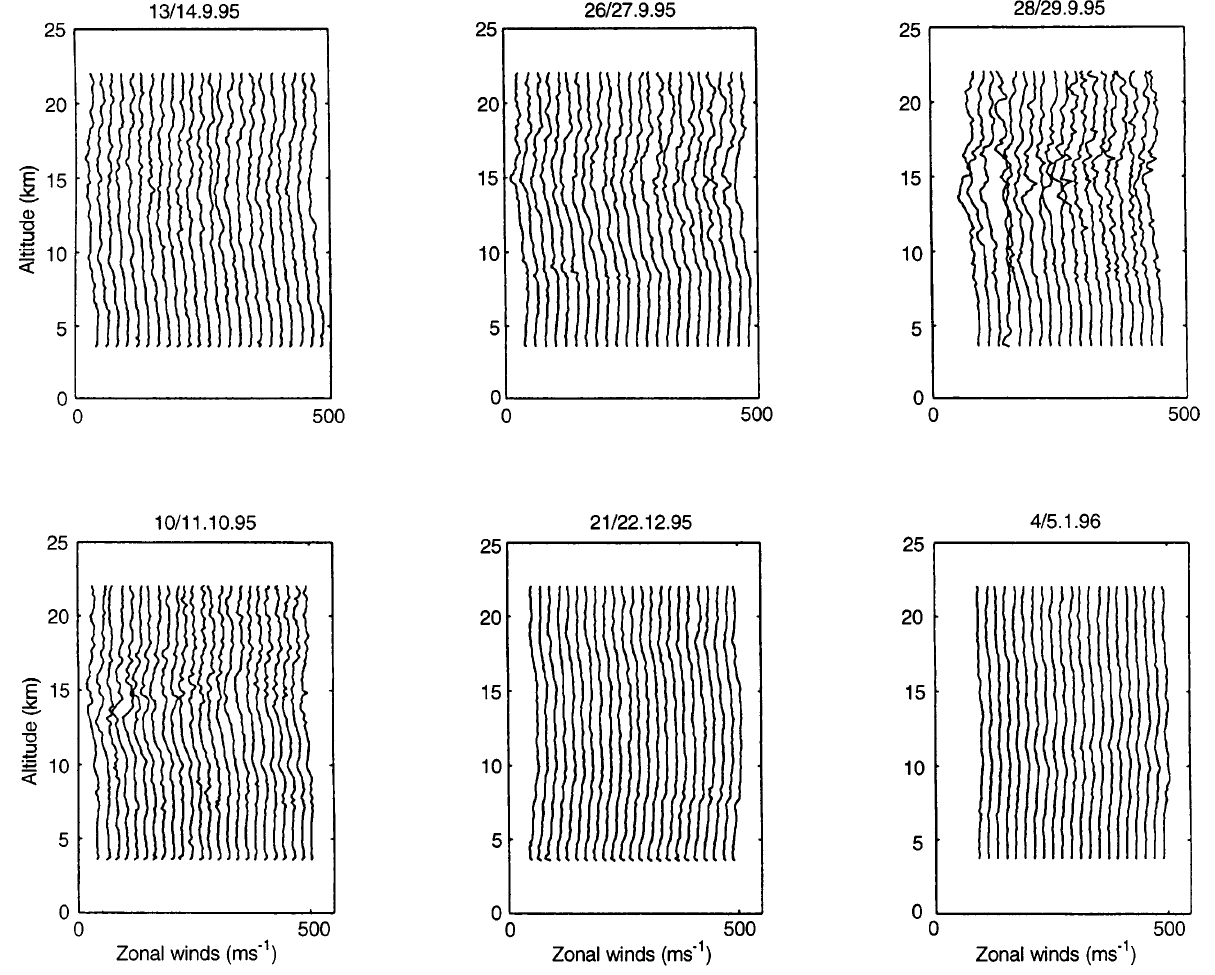
Fig. 1. Profiles of eastward winds on di(cid:128)erent days corresponding to observational hours. Successive profiles are displaced by 20 ms )